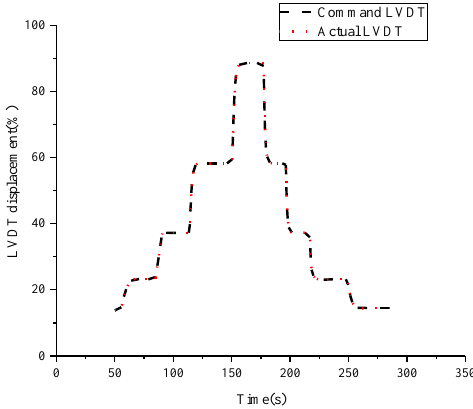
Figure 22. Full-digital simulation LVDT displacement closed loop control.